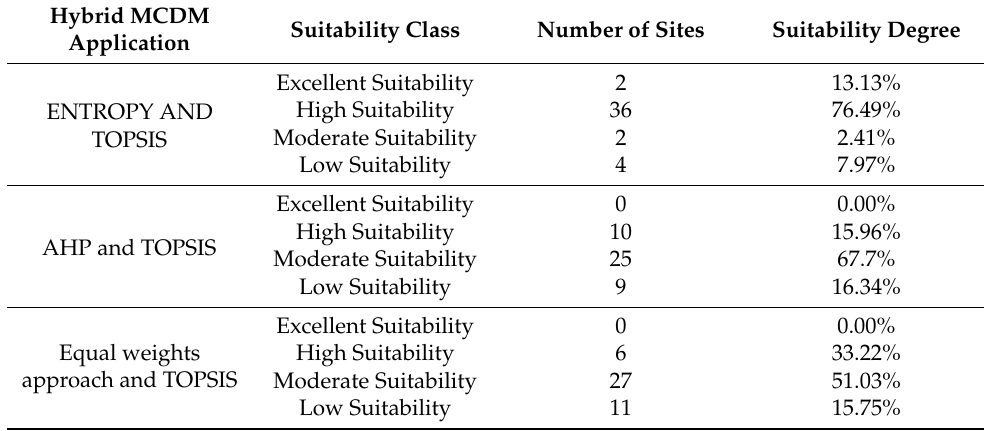
Table 6. The final PV site suitability results based on each hybrid MCDM